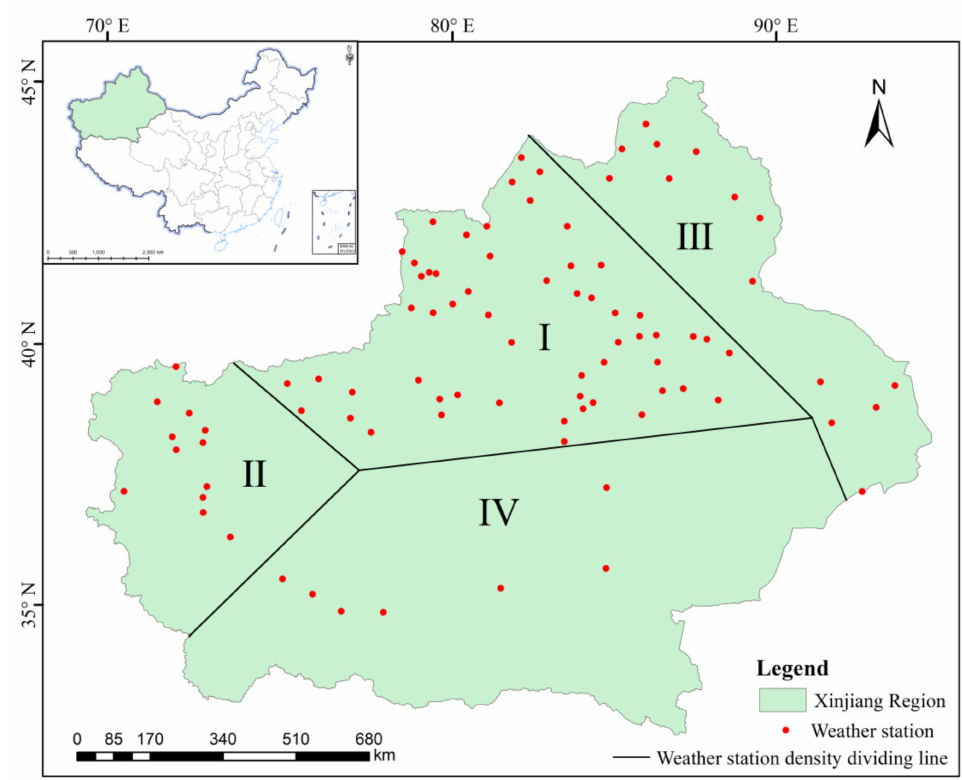
Figure 1. The 89 weather stations distributed in Xinjiang